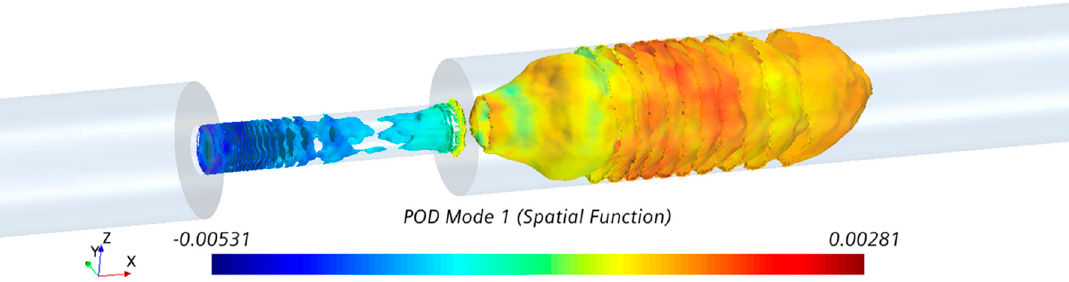
Figure 10. Visualization of POD mode 1 with the highest energy in the stenosis and post-stenotic region.